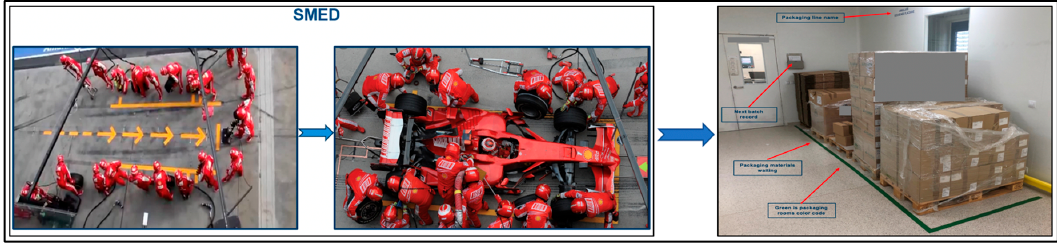
Figure 5. Externalization process [25].